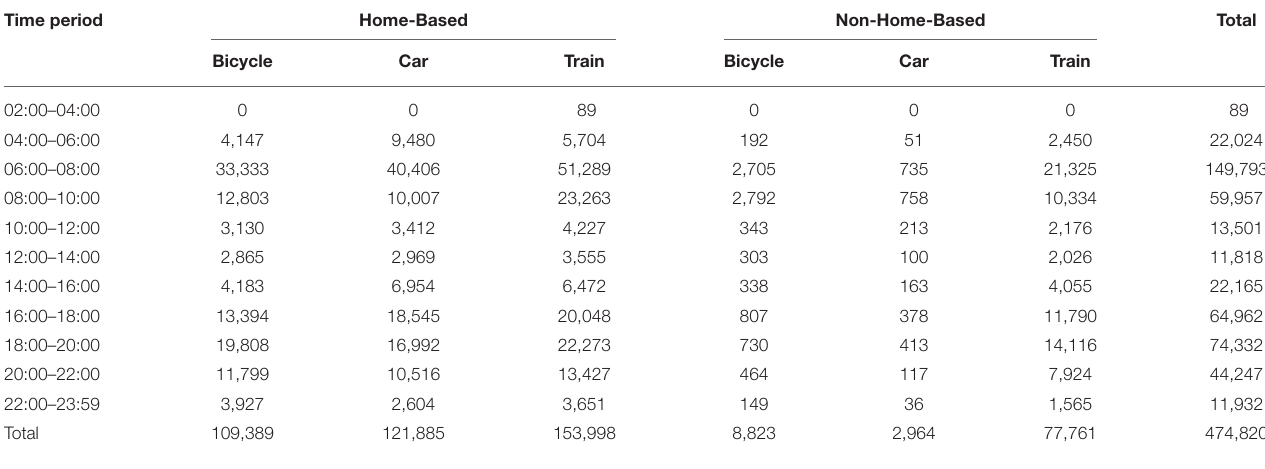
TABLE 4 | Difference in the total number of trips between the observed and the modeled origins–destinations (ODs). Time period Home-Based Non-Home-Based Total Bicycle Car Train